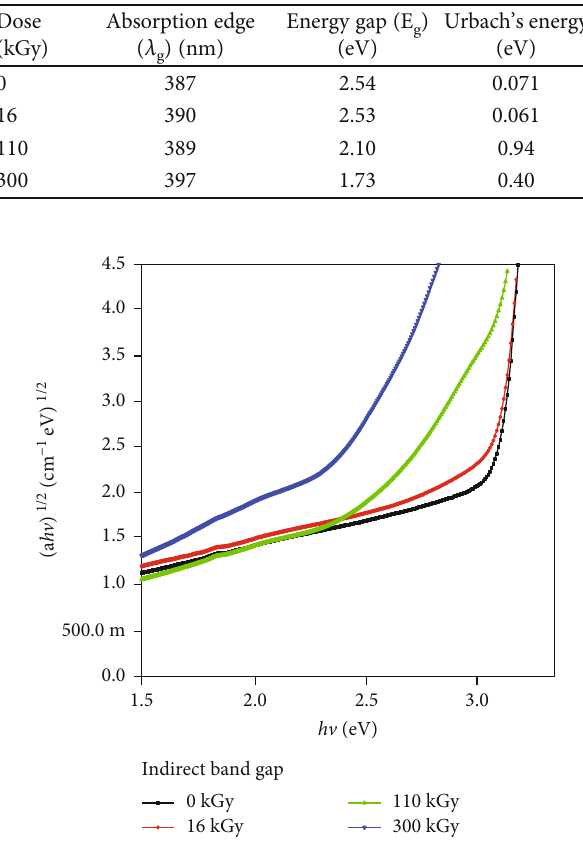
Figure 2: The optical E (eV) of UHMWPE polymer at 0 kGy, 16 g kGy, 110 kGy, and 300kGy radiation doses.